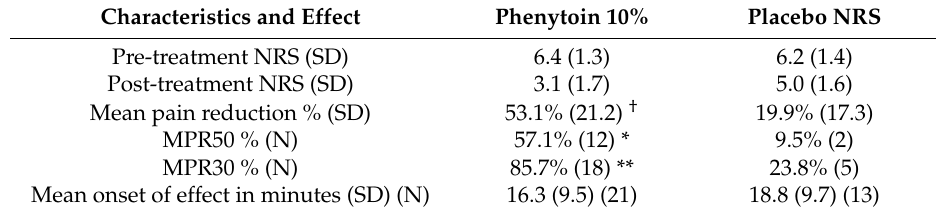
Table 3. Comparisons of effect between phenytoin 10% and placebo cream